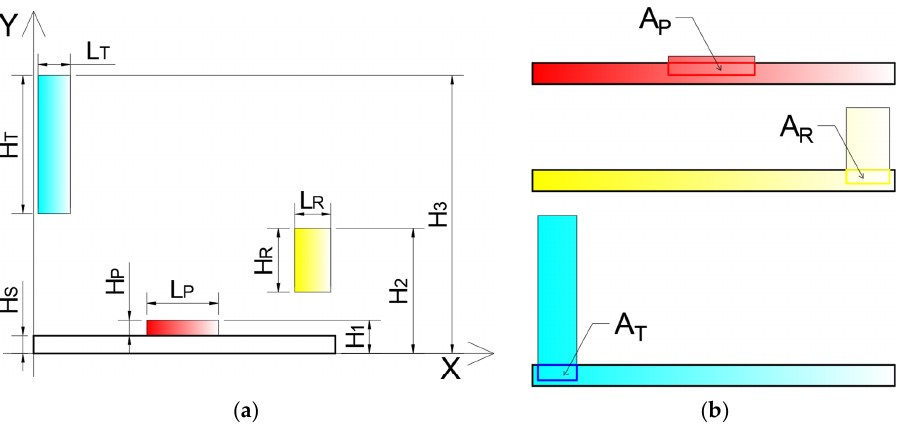
Figure 4. Schematic of the windows on the sleeve and the slot on the rotary spool. ( a ) Half of the unfolding schematic ( 0 ≤ θ ≤ π ). ( b ) Schematics of the three cross-sectional